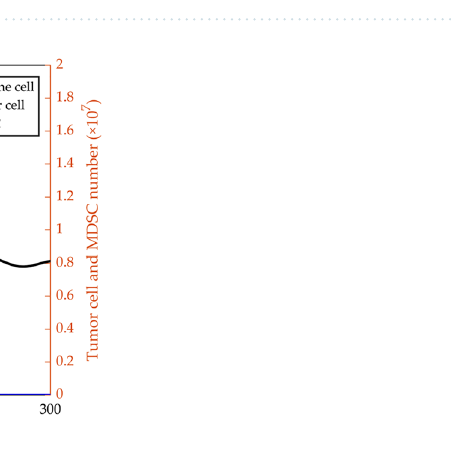
Figure 1. Mathematical simulation of tumor growth in the presence of MDSCs. By simulating the injection of 5 × 10 4 4T1 tumor cells in immune-competent mice, tumor growth dynamics, immune response, and MDSCs are shown. The published experimental data 23 are represented as mean ± SEM. Myeloid-derived suppressor cell: MDSC.